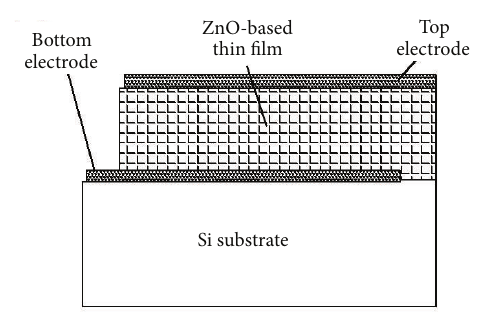
Figure 1: The structure of the ZnO-based thin film